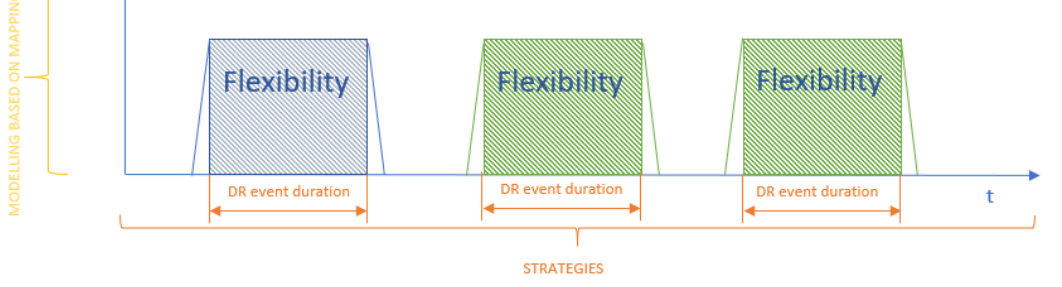
Figure 11. DR event description with repetitions.